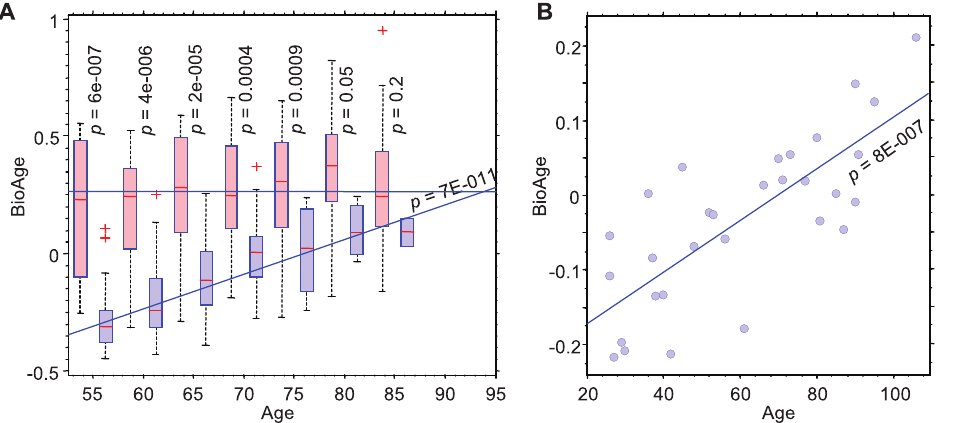
Figure 2. Aging score versus chronological age in PFC1. The box plots (A) demonstrate the distribution of BioAge in different 5-year long age segments and list the ANOVA p-values for the BioAge separation between normal and AD subjects in each chronological age segment. (B) Prediction of chronological age in the independent normal cohort using BioAge. The postmortem prefrontal cortex samples from individual of different age were profiled in an earlier study (GSE1572) [3]. BioAge was calculated based on average expression of several hundred genes from Table S2 (see Methods).